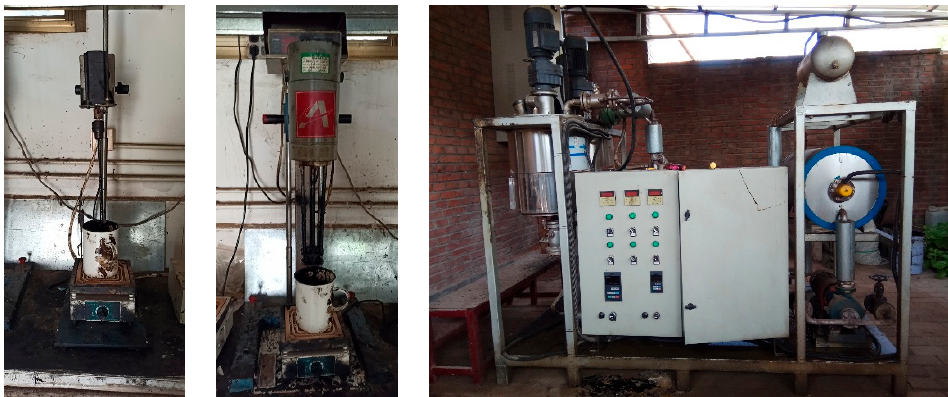
Figure 1. Equipment for high-content rubberized asphalt (HCRA) preparation.